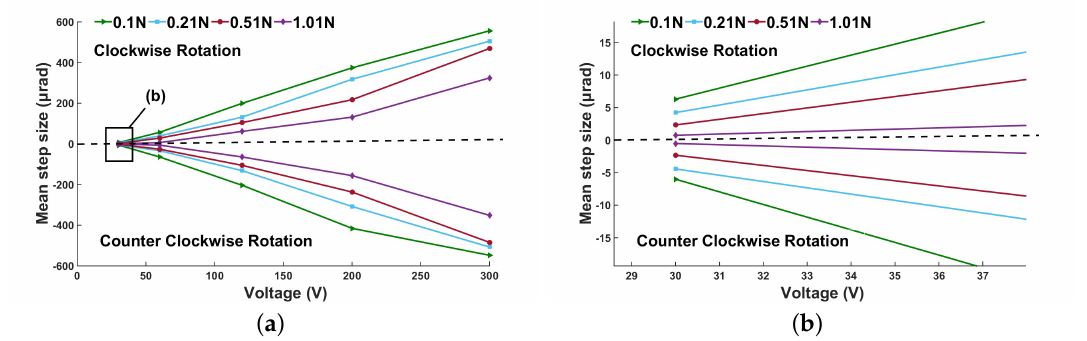
Figure 14. Mean step size depending on voltage for different preloads: ( a ) mean step size versus voltage for different preloads; and ( b ) magnified data for low voltage.